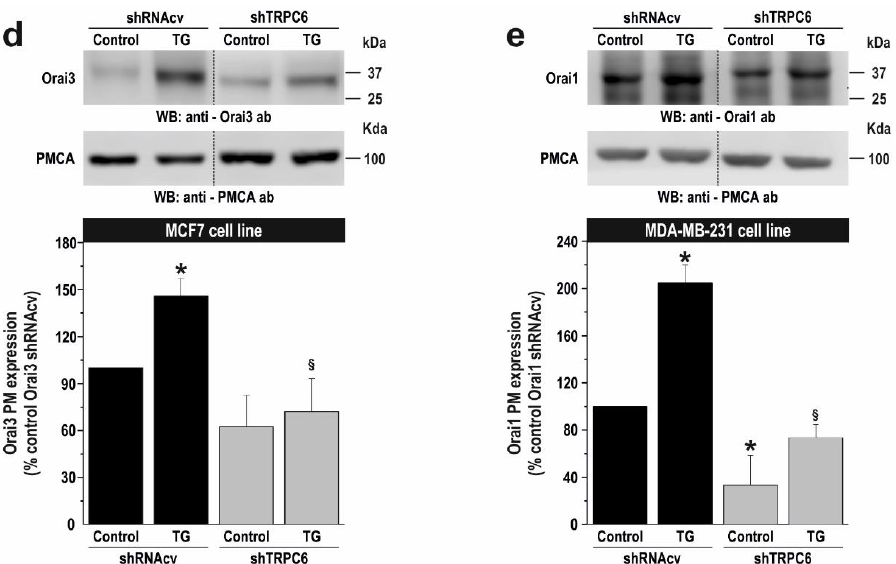
Figure 6. TRPC6 modulates plasma membrane localization of Orai1 and Orai3 in MDA-MB-231 and MCF7 breast cancer cells. ( a ) MCF10A, MCF7 and MDA-MB-231 cells were lysed and subjected to western blotting with anti-Orai1 or anti-Orai3 antibody, as indicated, followed by reprobing with anti- β -actin antibody for protein loading control. ( b,c ) MCF7 ( b ) and MDA-MB-231 ( c ) cells were left untreated or stimulated with TG (1 µM) for 3 min, lysed and whole cell lysates were immunoprecipitated (IP) with anti-TRPC6 antibody. Immunoprecipitates were subjected to 10% SDS-PAGE and subsequent western blotting with specific anti-Orai1 or anti-Orai3 antibody, as indicated. Membranes were reprobed with the antibody used for immunoprecipitation for protein loading control. The panels show results from one experiment representative of five others. Molecular masses indicated on the right were determined using molecular-mass markers run in the same gel. Bar graphs represent the quantification of TRPC6-Orai1 and TRPC6-Orai3 interaction in resting (control) and TG-treated cells. Results are presented as arbitrary optical density units, expressed as mean S.E.M. ( d,e ) MCF7 ( d ) and MDA-MB-231 cells ( e ) were transfected with shTRPC6 or scramble plasmid (shRNAcv), as indicated. Forty-eight hours after transfection, cells were stimulated with 1 µM TG in a medium containing 1 mM Ca 2+ , as indicated, and plasma membrane resident proteins were labeled by biotinylation, as described under Material and Methods. The biotinylated fraction was separated in 10% SDS-PAGE and analyzed by western blotting using either anti-Orai1 or anti-Orai3 antibody, as indicated. Membranes were reprobed with anti-PMCA antibody, as control. Positions of molecular mass markers are shown on the right. These results are representative of four separate experiments. Bar graphs represent the quantification of Orai3 ( d ) and Orai1 ( e ) surface exposition. Results are recorded as arbitrary optical density units, expressed as mean S.E.M. and presented as percentage of control (resting cells). * p < 0.05 as compared to resting cells transfected with shRNAcv. § p < 0.05 as compared to TG-treated cells transfected with shRNAcv. Similar results were obtained when cell lysates were immunoprecipitated with anti-Orai1 or anti-Orai3 antibody followed by western blotting with anti-TRPC6 antibody (Figure S1). These